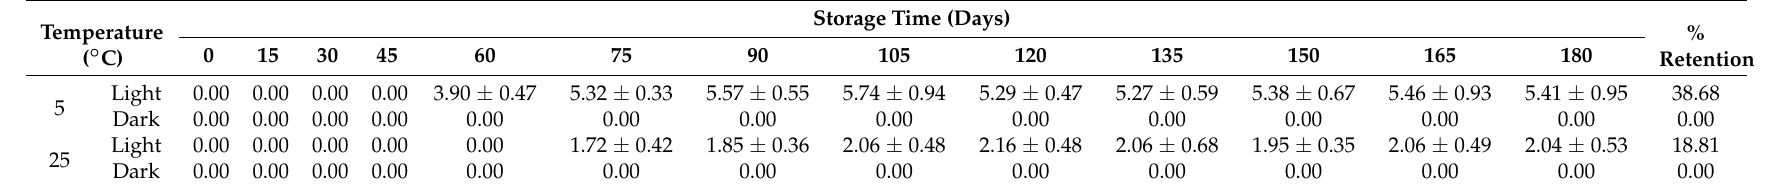
Table 7. Stability profile of 2,4-di- tert -butylphenol (2,4-DTBP) under different storage temperatures and light for 180